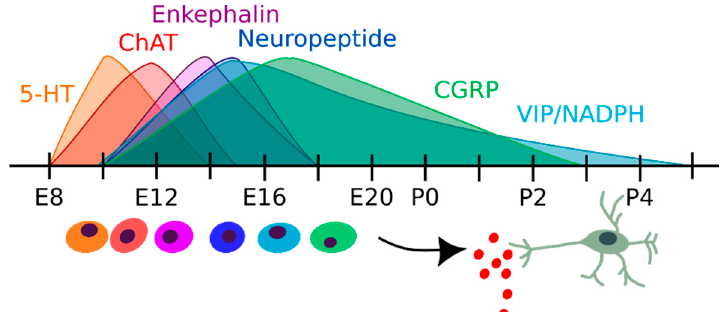
Figure 2. Time intervals in which different neuronal subtypes form. These are characterized by the expression of specific neurotransmitters.